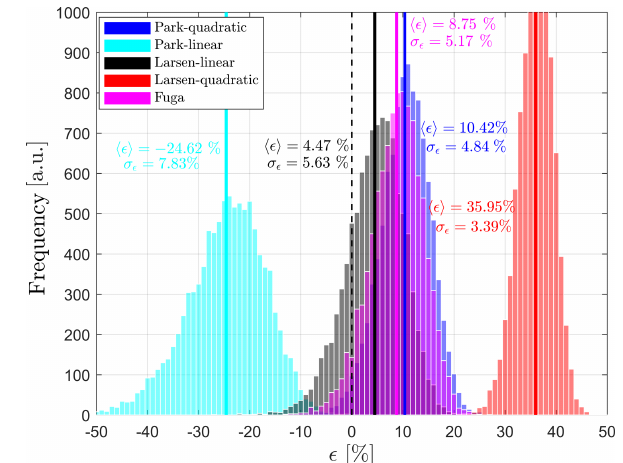
Figure 9. Distribution of the relative model error (cid:15) in estimating power losses (Eq. 3) of three wake models using 7440 10min boot- strapped samples from the Anholt wind-farm SCADA. The mean of each distribution is shown with a thicker vertical line. The mean and standard deviation of the distributions of (cid:15) , (cid:104) (cid:15) (cid:105) , and σ (cid:15) are also